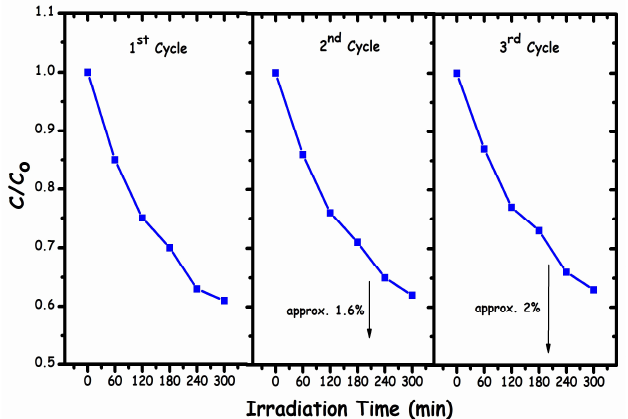
Figure 10. g-C 3 N 4 / α -Fe 2 O 3 nanocomposite stability.